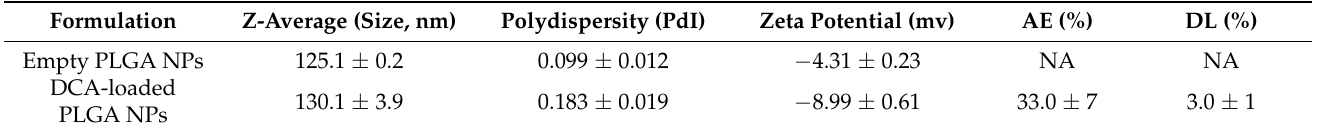
Table 3. Physicochemical properties of unloaded NPs and DCA-loaded PLGA NPs.